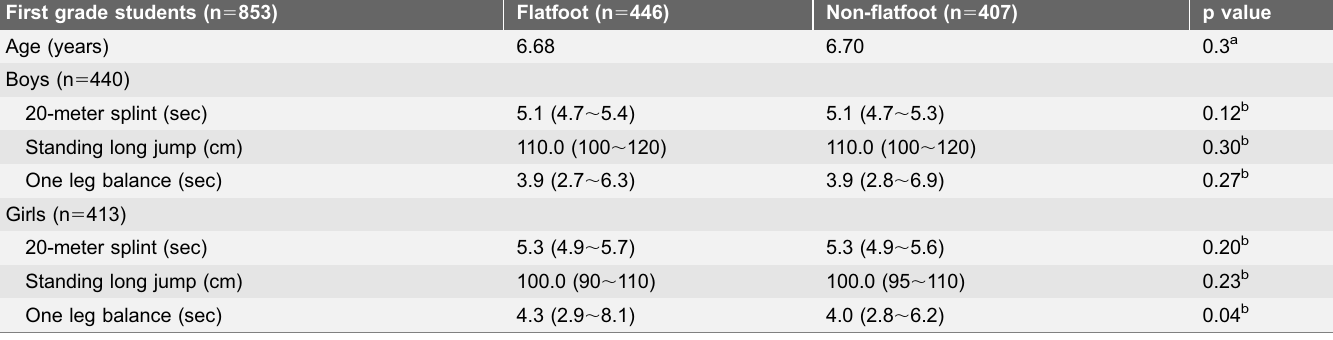
Fig. 5. Distribution of SAI data in different ages. Children of age of 6 years (n 5 695), 7 years (n 5 202), 8 years (n 5 159) and 9 years (n 5 172). doi:10.1371/journal.pone.0115808.g005 Table 1. Medians and inter-quarter ranges of physical fitness performance were compared between flatfoot and non-flatfoot children after stratifying age and